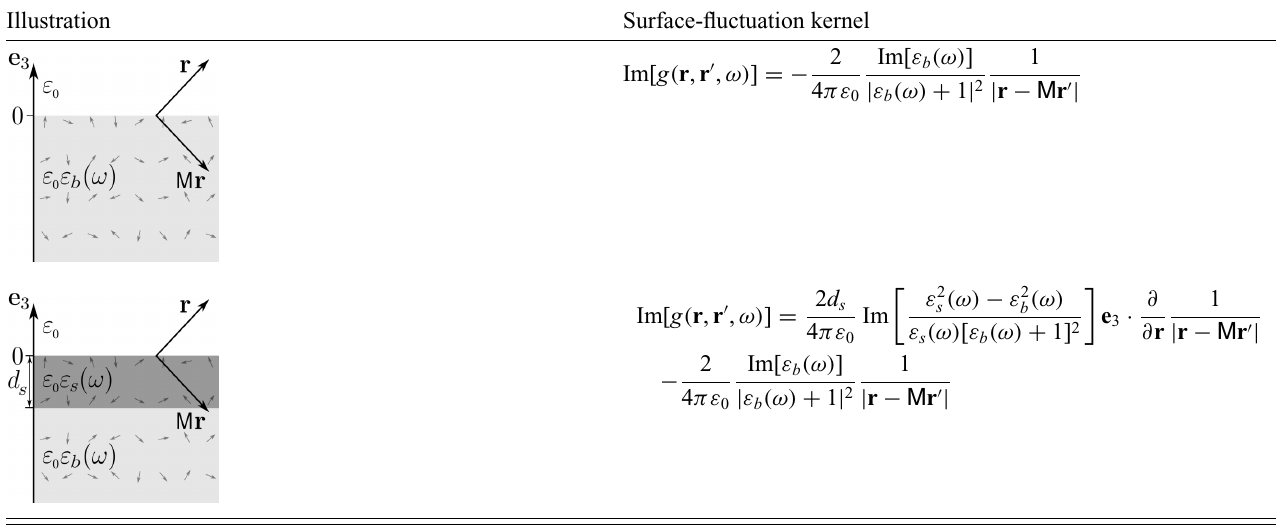
TABLE II. The resonant surface-fluctuation kernel for particles in front of a homogeneous planar surface (top) and a planar surface covered by a dielectric layer (bottom). For the latter case, we assume the particle to be at a large distance from the surface, r · e 3 , r (cid:3) · e 3 (cid:11) d s , as described in Sec. IV. In both expressions r and r (cid:3) are evaluated in vacuum, and the mirror tensor M = 1 − 2 e 3 ⊗ e 3 serves to reflect a vector at the surface plane. Illustration Surface-fluctuation